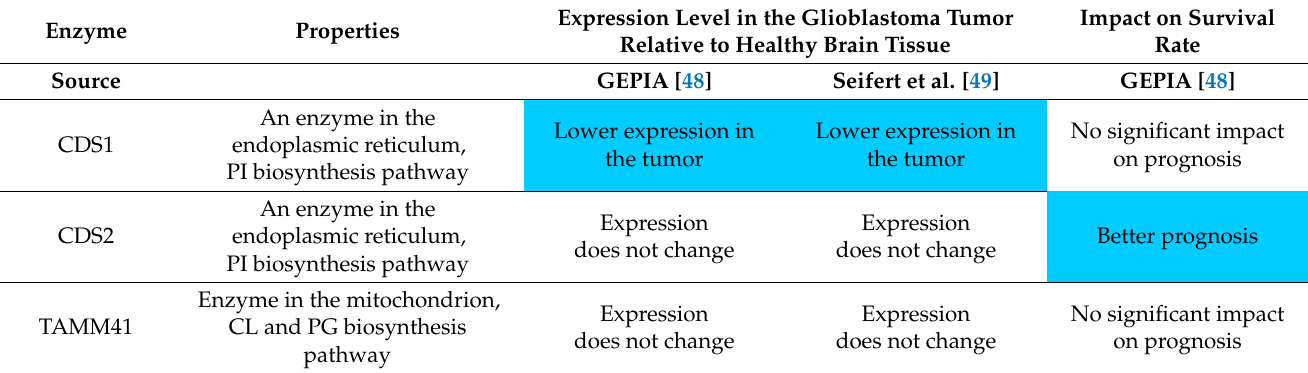
Table 10. Characteristics of enzyme CDP-DAG